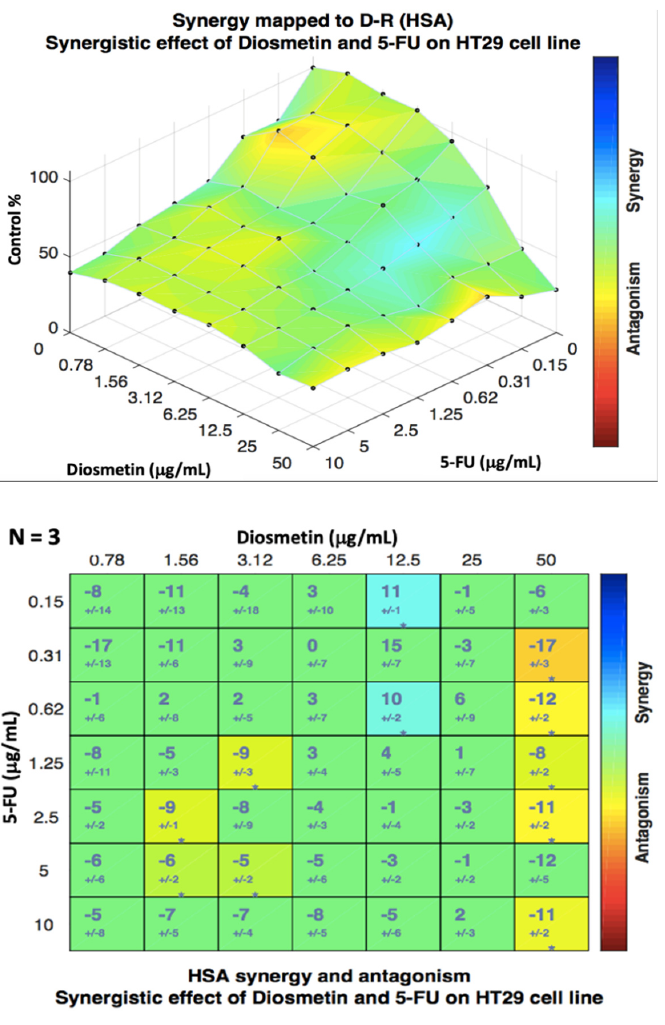
Figure 8. Isobologram analysis and synergism determination of combination therapy in HT29 cells using Combenefit software. Data were obtained from three different experiments ( n = 3).